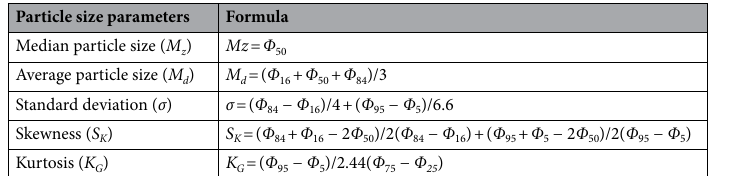
Table 2. The formulas for particle size parameters. Φ = − log 2 D , D is the particle size of the particle, unit: mm.